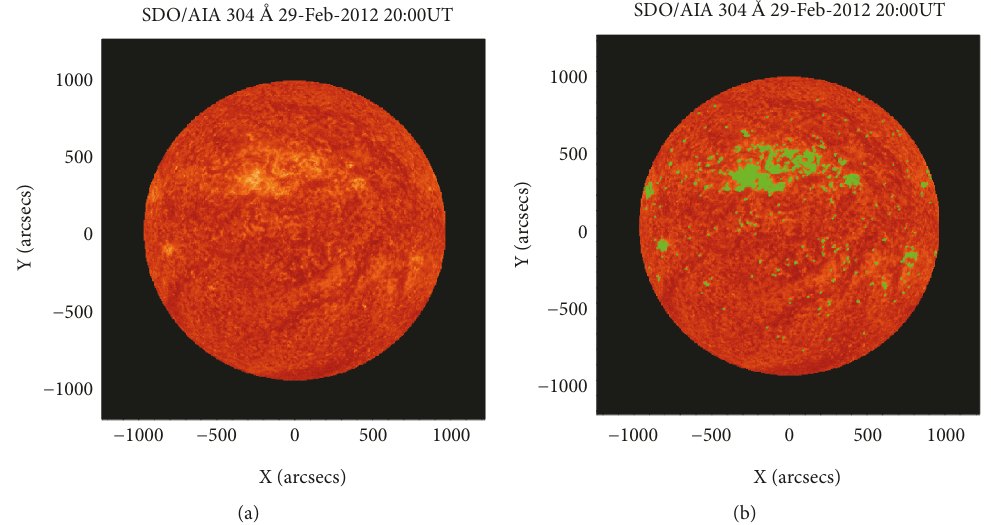
Figure 2: (a) The 304 ˚A EUV image on 29 February 2012; (b) pixels with intensities over 10 3.2 DN/s (green dots).